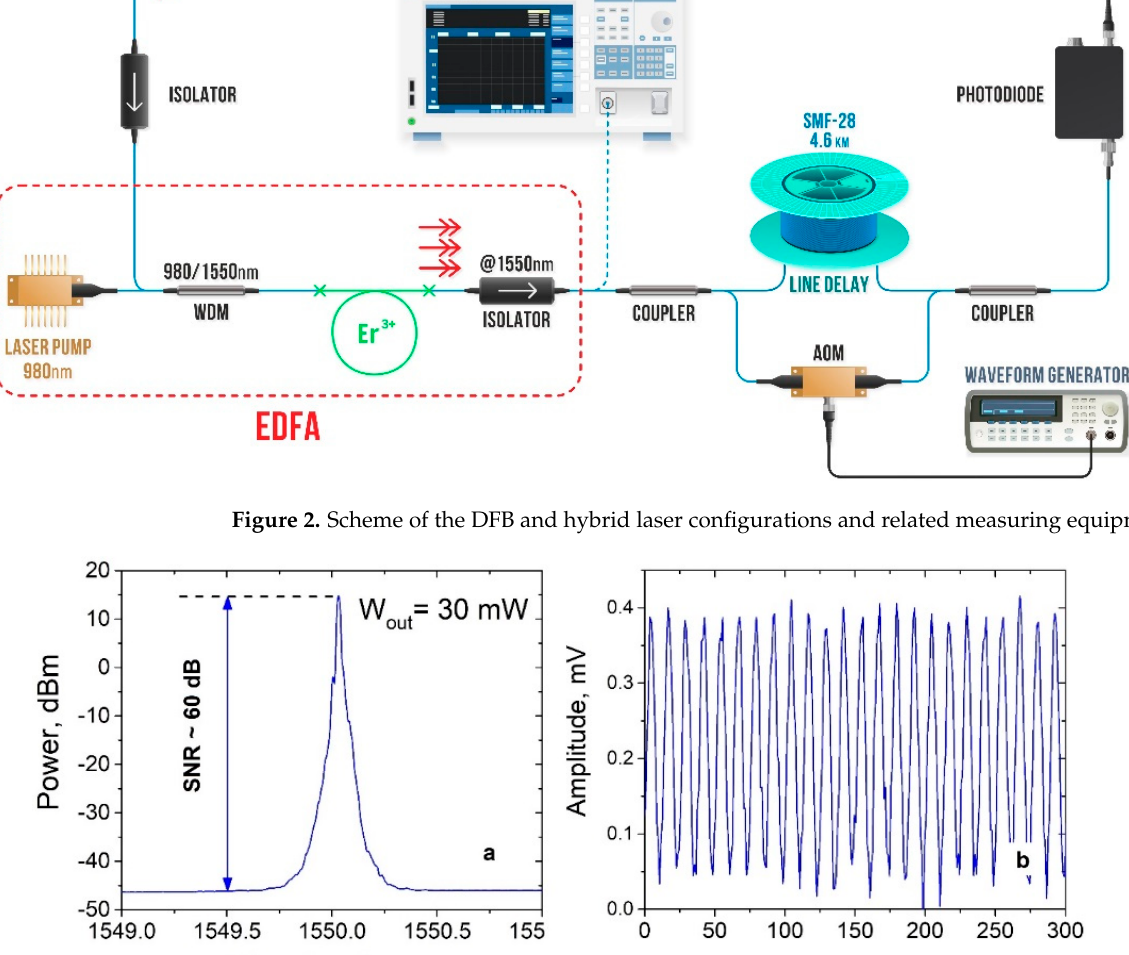
Figure 3. ( a ) Optical spectrum of the amplified signal at the input of MZI; ( b ) oscillogram of the beat